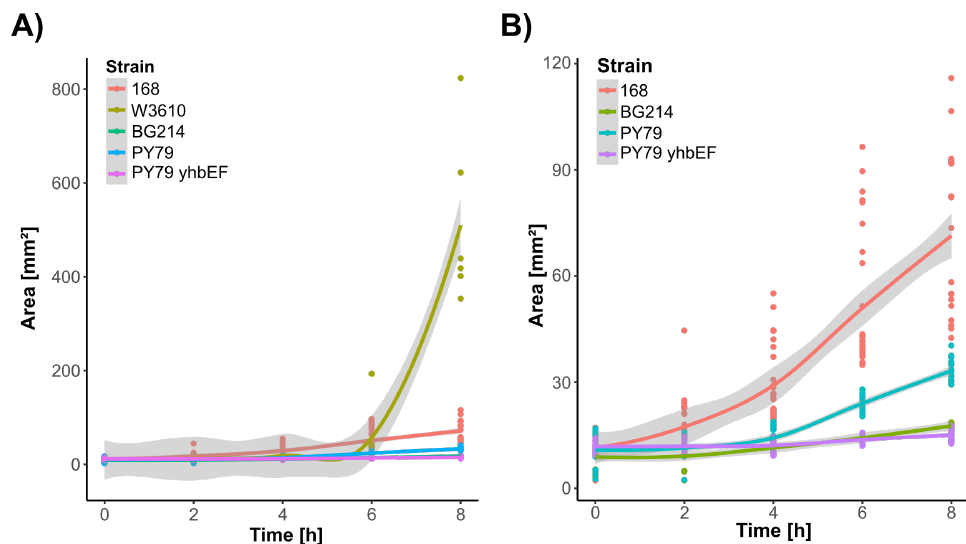
Figure 4. Motility of B. subtilis strains assayed on soft-agar plates illustrated as smoothed scatter plot of colony area plotted against incubation time. Conditional means were smoothed using LOESS regression with the 95% confidence intervals illustrated in gray. ( A ) Strains PY79 (blue), 168 (red), PY79 (turquoise), BG214 (green), W3610 (olive-green) and the flagella-deficient PY79 derivate PY79 yhbEF (purple) are compared, conditional means were smoothed using LOESS regression. ( B ) Separate comparison of 168 wt, PY79 wt, BG214 and PY79 yhbEF. Figure created using